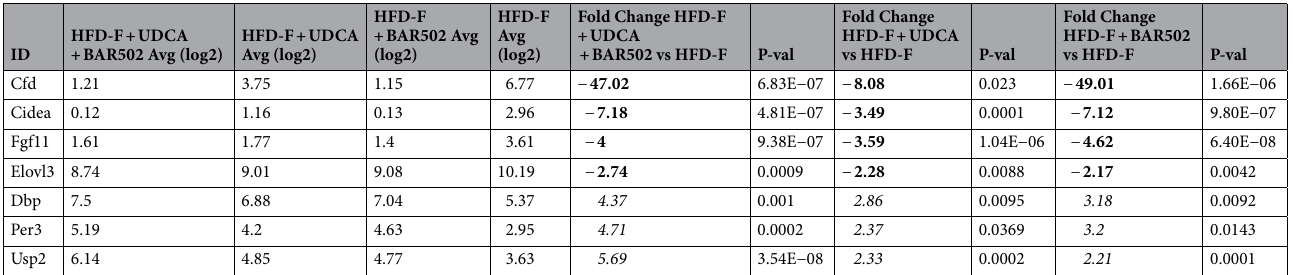
Table 1. Genes modulated by the three analyzed treatments (downregulated genes in bold, upregulated genes in italics).